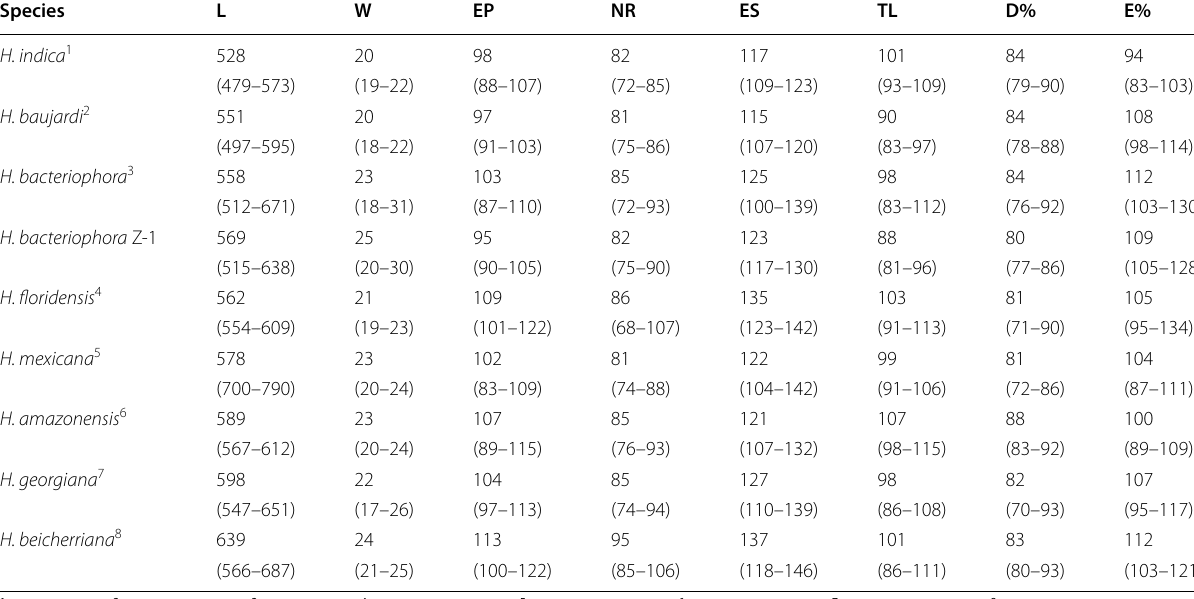
1 Poinar (1992); 2 Phan et al. (2003); 3 Poinar (1990); 4 Nguyen et al. (2006); 5 Nguyen et al. (2004); 6 Andalo et al. (2006); 7 Nguyen et al. (2008); 8 Li et al. (2012)